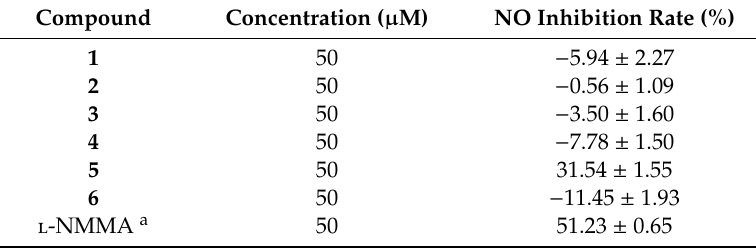
Table 3. NO inhibitory e ff ects of compounds 1 – 6